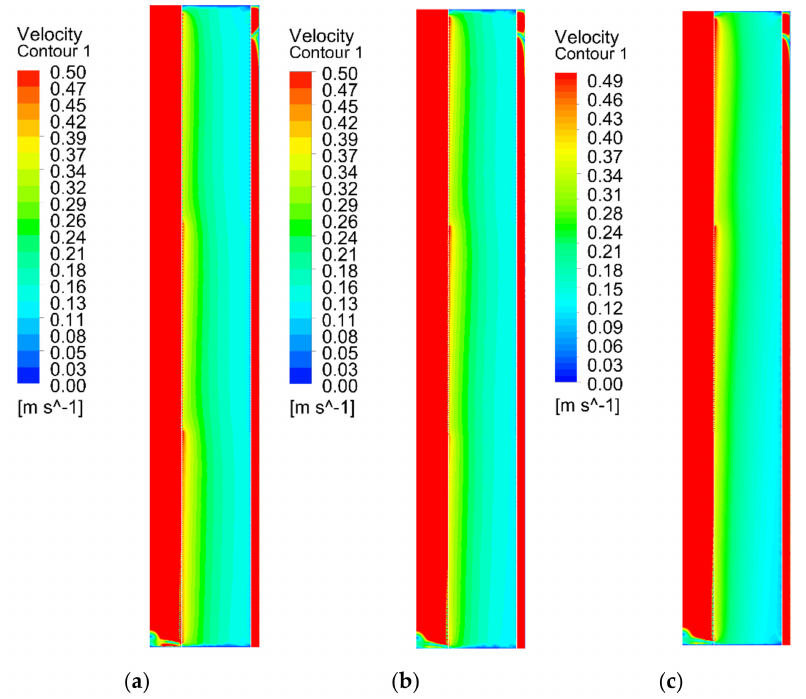
Figure 9. Velocity contour at the location of the center pipe; ( a ) Velocity contour for strategy 1; ( b ) Velocity contour for strategy 2; ( c ) Velocity contour for strategy